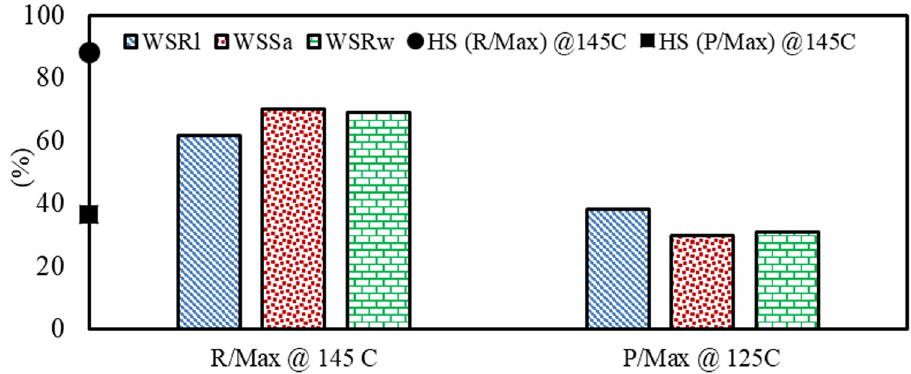
Figure 23: Final percentages of recovered and permanent strain at the termination of the fi rst cycle.